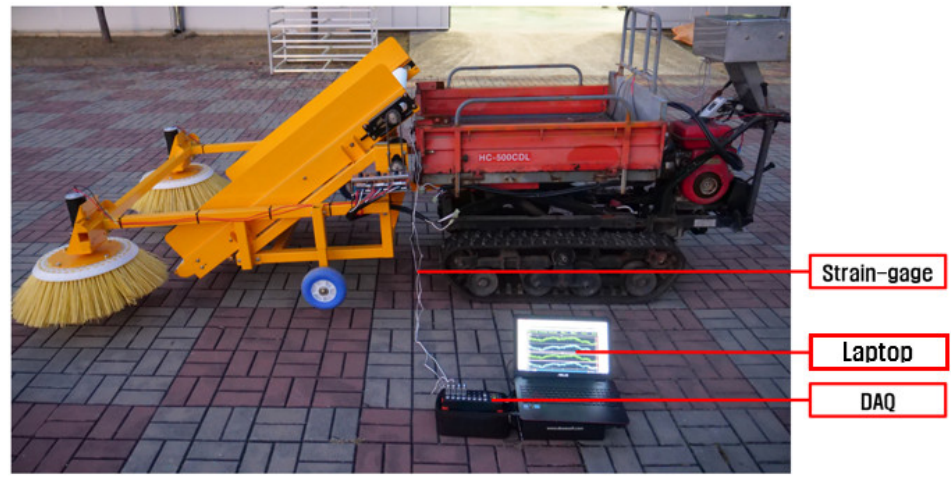
Figure 6. Configuration of measurement system.